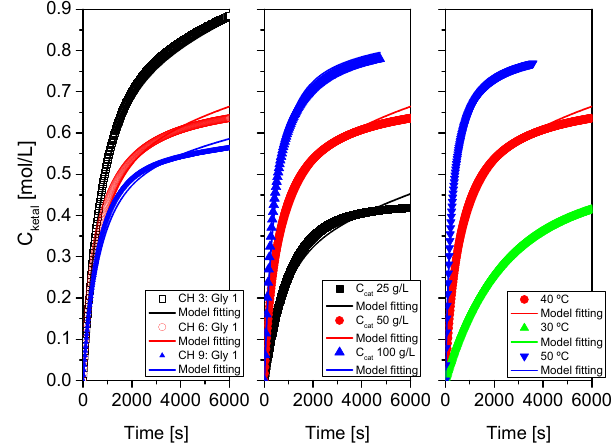
Figure 18. Fit of the proposed kinetic model to all data from system 3 (cyclohexanone + glycerol). Points correspond to the experimental data while lines show the fit of the model to such data.